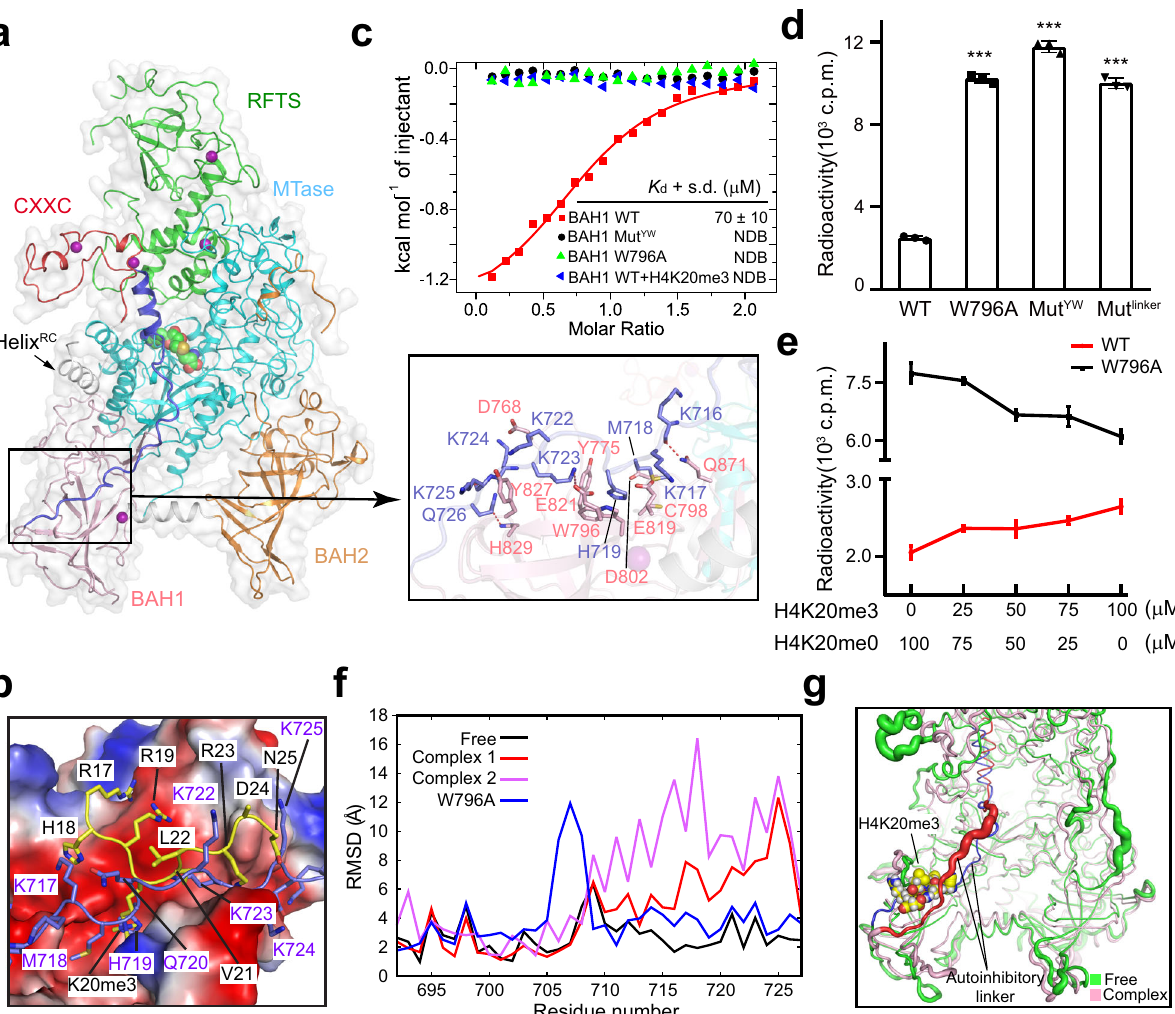
Fig. 2 H4K20me3 binding allosterically stimulates DNMT1 activity. a Ribbon and surface diagram of the structure of hDNMT1 351 – 1600 (PDB 4WXX [10.2210/pdb4WXX/pdb]), with individual segments color coded. The RFTS – CXXC linker helix is denoted as Helix RC . The detailed interactions between the autoinhibitory linker and the BAH1 domain are shown in the expanded view. The hydrogen bonds are shown as dashed lines. b Close-up view of the structural overlay between hDNMT1 351 – 1600 (PDB 4WXX [10.2210/pdb4WXX/pdb]) and the bDNMT1 BAH1 – H4K20me3 complex, with the autoinhibitory linker and the H4K20me3 peptide colored in slate and yellow, respectively, and the corresponding binding site in hDNMT1 351 – 1600 shown as electrostatic surface. The bDNMT1 BAH1 domain was removed for clarity. c ITC binding analysis of the interaction between hDNMT1 BAH1 , either WT, W796A, or Mut YW , and the autoinhibitory linker peptide, in the absence of presence of the H4 14 – 25 K20me3 peptide. d DNA methylation activity of hDNMT1 351-1600 , WT, W796A, Mut YW , or Mut linker . Data are mean ± s.d. ( n = 3 biological replicates). Statistical analysis for WT vs. mutants used two-tailed Student ’ s t test. *** p < 0.001. e H4K20me3-dependent DNA methylation activity of hDNTM1 351 – 1600 , either WT or W796A. The total concentration of H4 14 – 25 K20me0 and H4 14 – 25 K20me3 peptides were maintained at 100 μ M to eliminate the substrate-competing effects of the H4 peptides. Data are mean ± s.d. ( n = 3 biological replicates). f The RMSD values obtained for the autoinhibitory linker in the structural models of WT (PDB 4WXX [10.2210/pdb4WXX/pdb]) or W796A hDNMT1 351 – 1600 and the hDNMT1 351 – 1600 -H4K20me3 complex (complex 1 and complex 2) during 100 ns MD simulations. g Sausage view of the RMSF values of the autoinhibitory linker in peptide-free and H4K20me3-bound hDNMT1 351 – 1600 (complex 2), colored in blue and red, respectively. Source data are provided as a Source Data fi af fi nity of the latter. ITC analysis revealed that the Mut linker incubation with an increasing ratio of H4 14 – 25 K20me3 vs. mutation enhanced the hDNMT1 351 – 1600 – H4K20me3 binding af fi nity by two to threefold (Supplementary Fig. 3b and Supplementary Table 1), consistent with the notion that the autoinhibitory linker and H4K20me3 compete for BAH1 binding. Furthermore, in vitro DNA methylation assays indicate that W796A, Mut YW , and Mut linker mutations all lead to enhanced enzymatic activity of DNMT1 by four to fi vefold (Fig. 2d), suggesting that disruption of the interactions between the BAH1 domain and the autoinhibitory linker helps relieve DNMT1 ’ s autoinhibition. Consistently, under fi xed peptide concentration,